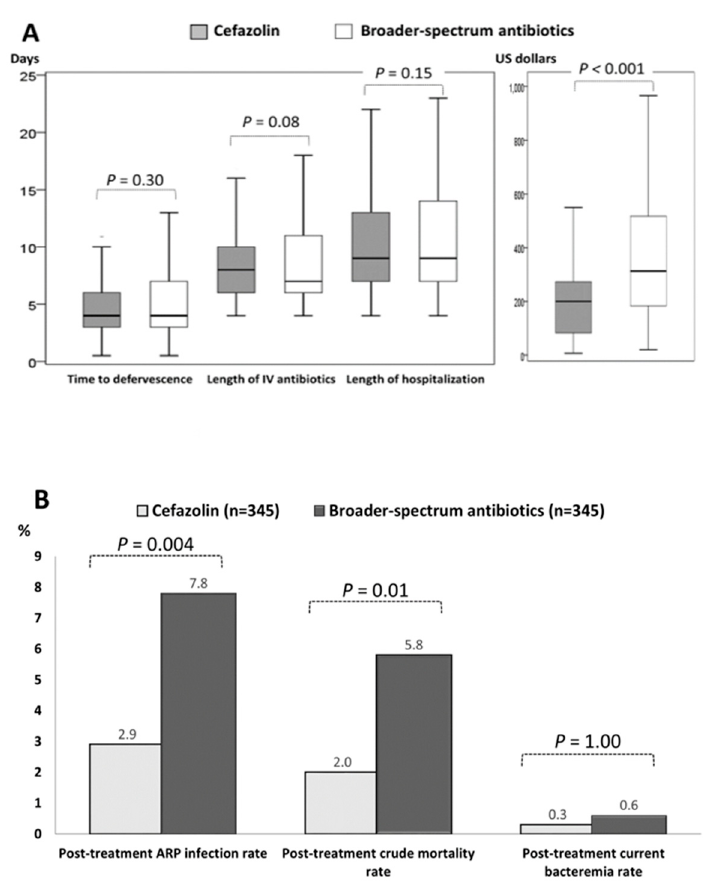
Figure 2. Boxplots for early ( A ) and late ( B ) outcomes in response to definitive therapy in the matched cohort. ARP = antimicrobial-resistant pathogen; IV = intravenous.